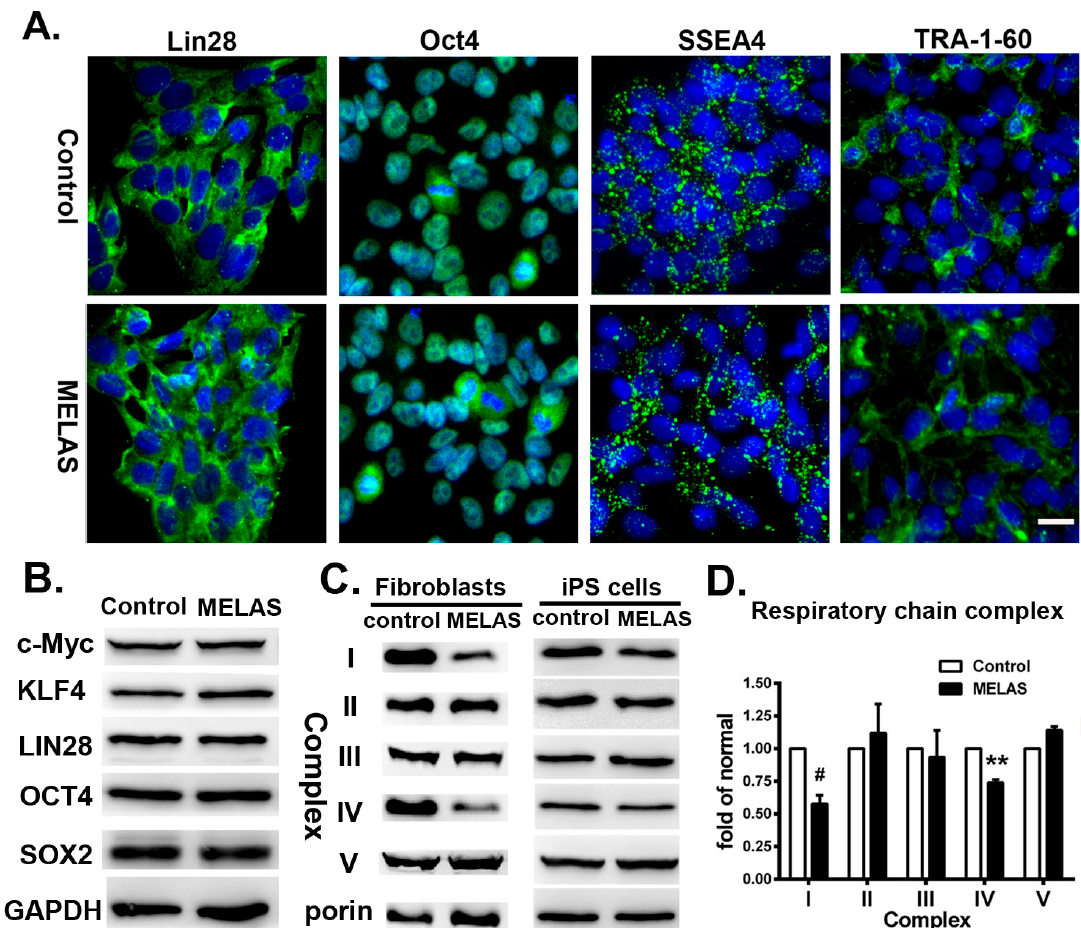
Figure 1. Induced pluripotent stem (iPS) cells derived from fibroblasts of mitochondrial encephalomyopathy, lactic acidosis, and stroke-like episodes (MELAS) syndrome patient. ( A ) Immunocytochemical analyses showed positive expression of pluripotency markers Lin28, Oct4, SSEA4 and Tra-1-60 on both control and MELAS iPS cells. ( B ) Western blots showing the expression of c-Myc, Klf4, Lin28A, Oct4, Sox2 in iPS cells. ( C ) Western blots showing the expression of respiratory complexes in fibroblasts and iPS cells, respectively. ( D ) Quantification of respiratory chain complex proteins in iPS cells represented as fold of normal. All measurements are expressed as mean values ± SEM, n = 3–5. Comparisons with the control cells were performed by the ANOVA-test. ** p < 0.01, # p < 0.001, versus control. Scale bar: 20 μ m.